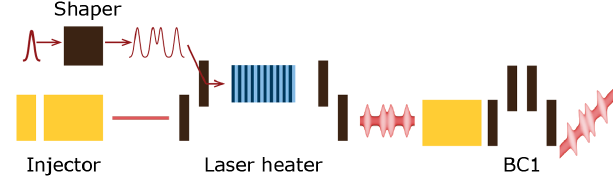
FIG. 1. Cartoon of laser heater shaping at an FEL facility. A high-repetition rate laser can be used to program complicated patterns into the slice energy spread. After bunch compression (BC1), the energy spread is converted to a current